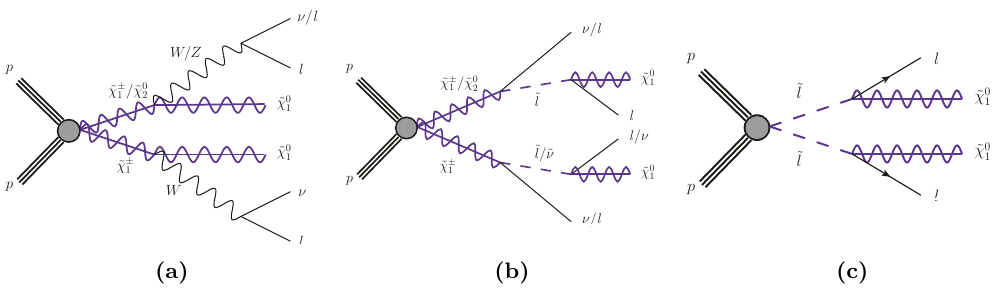
Figure 3. Diagrams corresponding to the SUSY searches at the ATLAS detector, with two and three leptons in the final state alongside missing energy, which put the strongest constraints on the model: 3(a) W/Z mediated decays, 3(b) ˜ l / ˜ ν mediated decays and 3(c) direct slepton pair